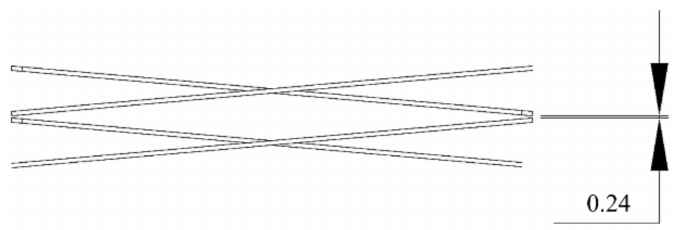
Figure 6. Two groups of susceptor interval diagram (susceptor front view).